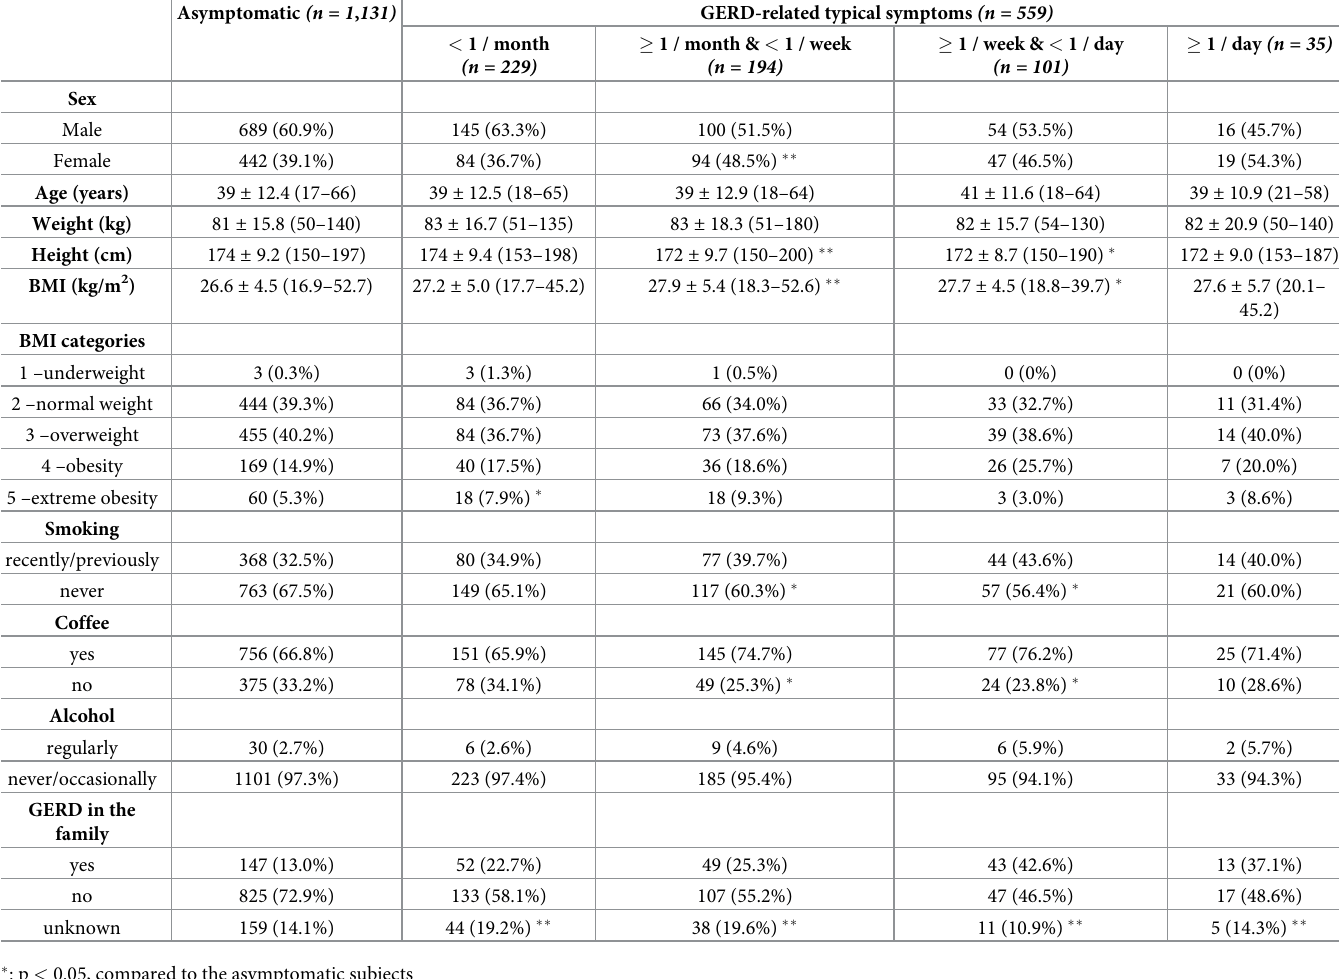
Table 4. Socioeconomical factors of blood donor volunteers with any GERD-related typical symptoms. Age, weight, height and BMI are presented with mean ± SD and range. Asymptomatic (n = 1 ,